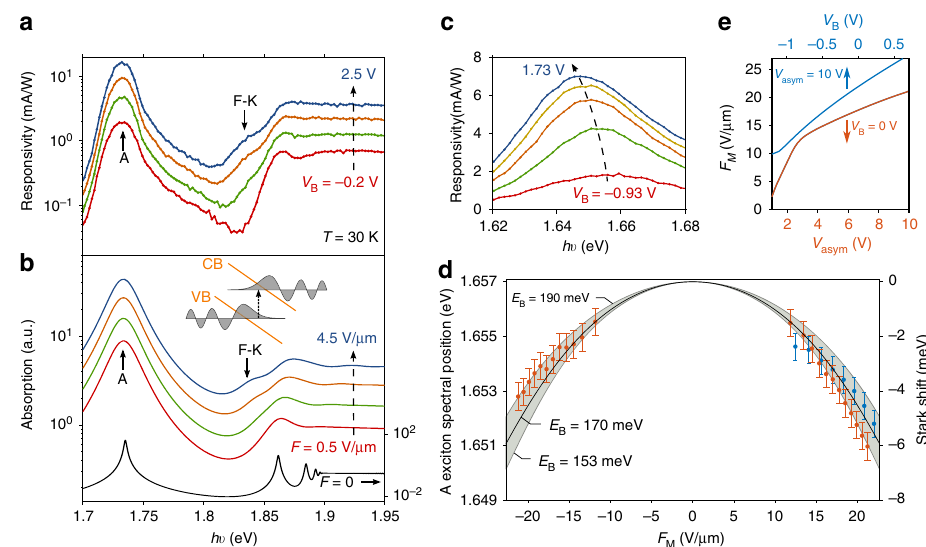
Fig. 2 Electroabsorption and Stark effect in monolayer WSe 2 p – n junctions. a Responsivity (PC/ P ) spectra measured at the p – n junction of device 3 (Supplementary Fig. 2) for various V B , with a laser power P = 1 μ W and T = 30 K. The spectra are vertically shifted (by a factor of 1.5) for clarity. b Absorption spectra calculated using a Wannier – Mott exciton model at different in-plane electric fi elds F . The solid colored lines (left axis) were calculated with a phenomenological line shape broadening of 15 meV, while the black solid line (right axis) was calculated without broadening. All spectra are vertically shifted for clarity. Inset: Schematics illustrating the sub-bandgap, fi eld-induced absorption increase due to the Franz – Keldysh (F-K) effect. The application of an in-plane fi eld tilts the conduction (CB) and valence band (VB) of the semiconductor (orange lines) and allows the wave functions of the free electrons and holes (gray shaded curves) to leak into the bandgap, which results in an increase of the sub-bandgap absorption (dotted arrow). c Responsivity spectra (around the A exciton) measured on device 1 (shown in Fig. 1c) at various V B , with a laser power P = 0.5 μ W, V asym = 10 V and at room temperature. d Position of the A exciton as a function of the calculated F M for the same values of V asym and V B as the one shown in e . Orange data points correspond to different values of V asym at V B = 0 V, while blue data points represent different values of V B at V asym = 10 V. Error bars correspond to the spectral resolution of our measurements. The calculated Stark shifts (right axis) induced by the F M are represented by the black solid line ( E B = 170 meV) and the gray shaded curves ( E B = 153 and 190 meV). The latter values represent the uncertainty bounds of E B arising from the uncertainty (95% con fi dence interval) in the measured polarizability. e Maximum in-plane electric fi eld F M calculated as a function of V asym (with V B = 0 V, solid orange line) and as a function of V B (with V asym = 10 V, solid blue